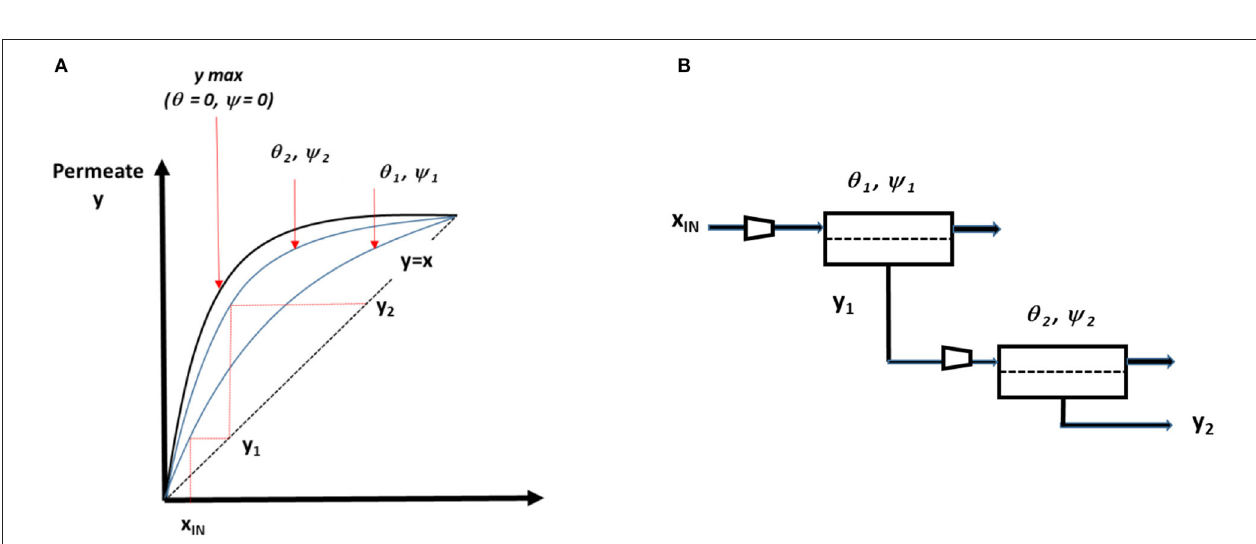
FIGURE 9 | Generic composition curve of a multistage membrane process for DAC and the corresponding two-stage process design. Simulations enable the permeate composition to be predicted for a set of pressure ratio, stage cut, and membrane performances. The maximal purity, shown by the upper bold line on graph (A) is obtained for vanishing pressure ratio (i.e., maximal energy requirement) and vanishing stage cut (i.e., minimal productivity). Different purity performances can be obtained for each set of ψ and θ . CO 2 purity can gradually increase as a function of each module outlet (permeate) and operating conditions. An infinite number of solutions are possible for a given target composition (y 2 for the two-stage example shown). The best set of ψ and θ values can be identified by process optimization methods if a cost function is defined. (B) Example of a multistage membrane process.